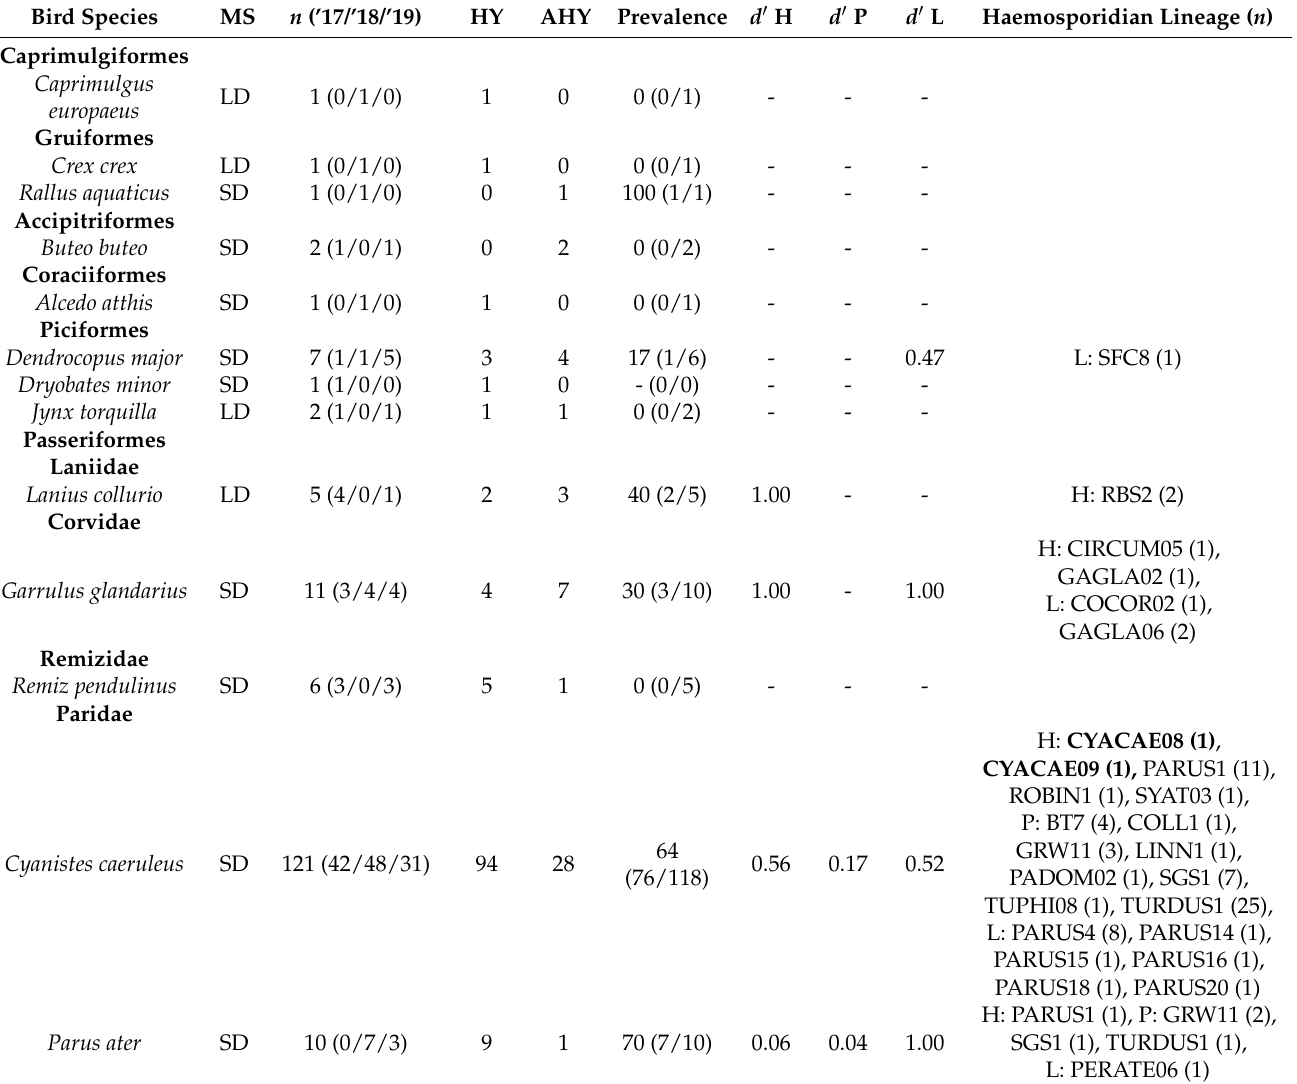
Table 1. List of avian species sampled and haemosporidian parasites detected in Drienovec, Slovakia, during 2017, 2018 and 2019. For each bird species we report migratory strategy (MS: SD = short-distance migrant, LD = long-distance migrant), number of sampled individuals during three years and for two age classes (AHY: after-hatch-year, HY: hatch-year), haemosporidian prevalence in percent (proportion), values of structural parasite specificity in terms of the d (cid:48) index ( d (cid:48) H, P and L: specificity for Haemoproteus , Plasmodium and Leucocytozoon lineages, respectively), and haemosporidian cytochrome b lineages (H: Haemoproteus , P: Plasmodium and L: Leucocytozoon ). New lineages are in bold. Note that it was not possible to identify lineage for each positive sample while multiple lineages were often identified in individual blood samples. Furthermore, the d (cid:48) index was not possible to calculate for each parasite genus due to sample size limitations. Sample sizes for prevalence may not correspond with the number of sampled birds per species as it was not possible to determine infection status for some ( n = 76) of the